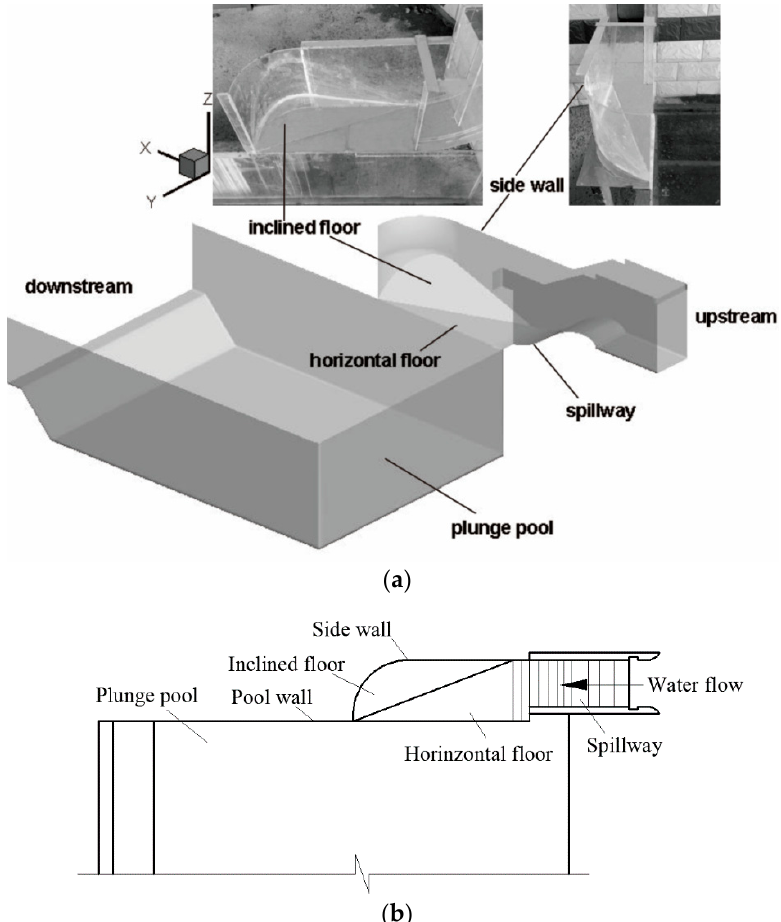
Figure 1. Definition of the streamwise-lateral discharge spillway: ( a ) 3-D model; ( b ) plan view.